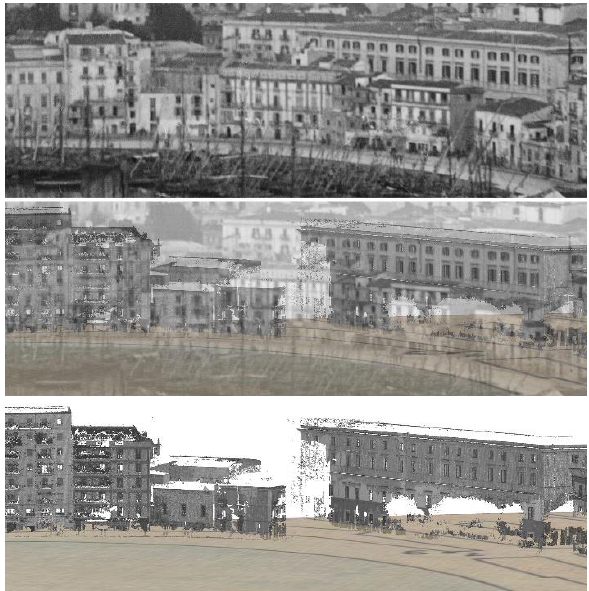
Figure 5: Visual validation of external orientation.